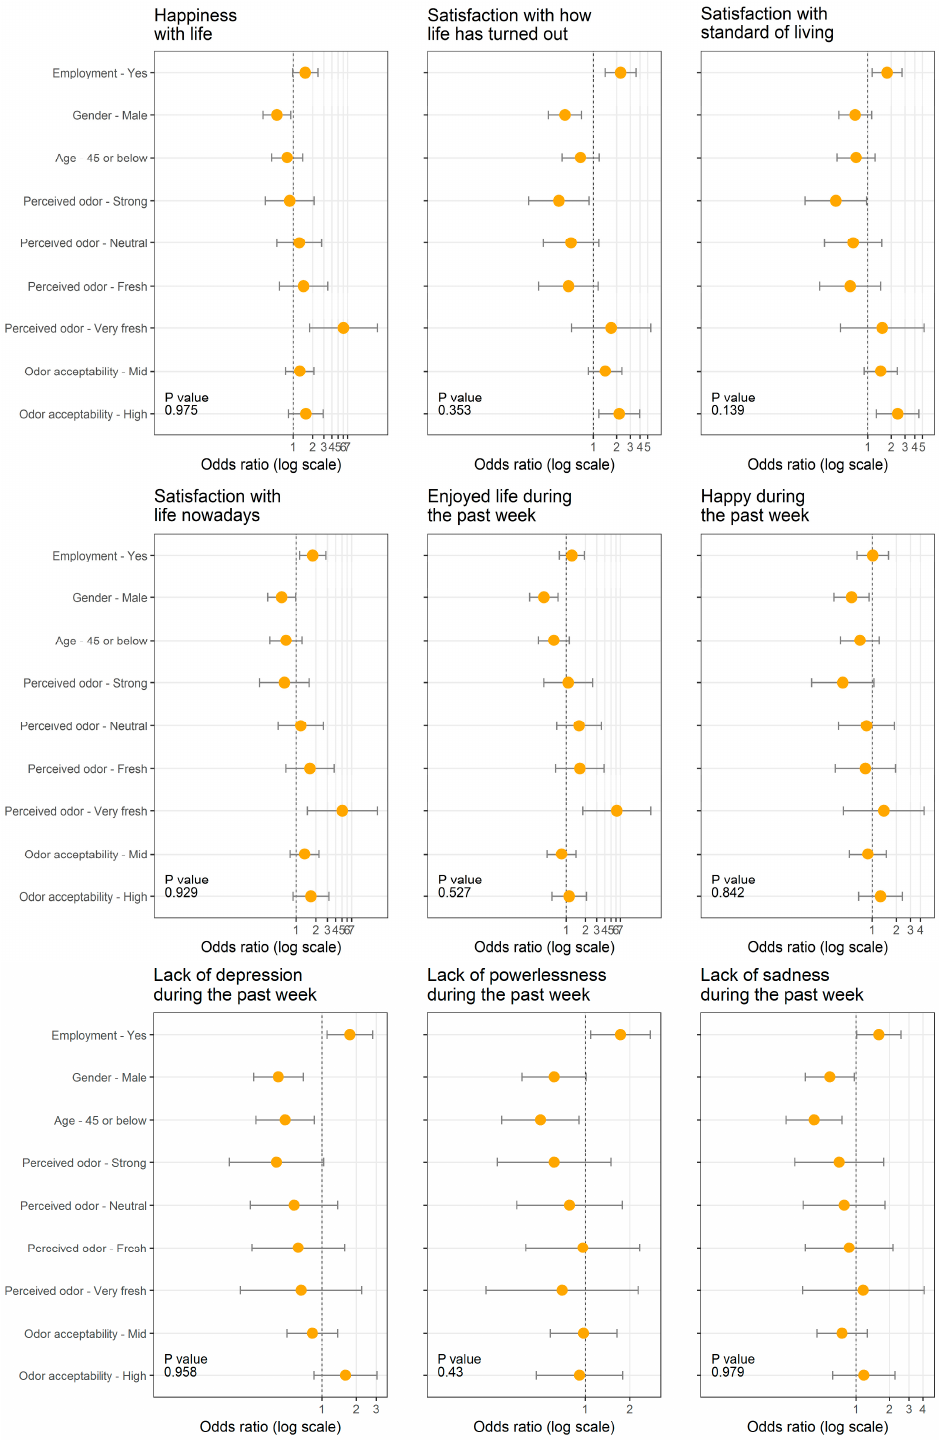
Figure 3. Forest plots of the effects of the five independent variables on the measures of subjective